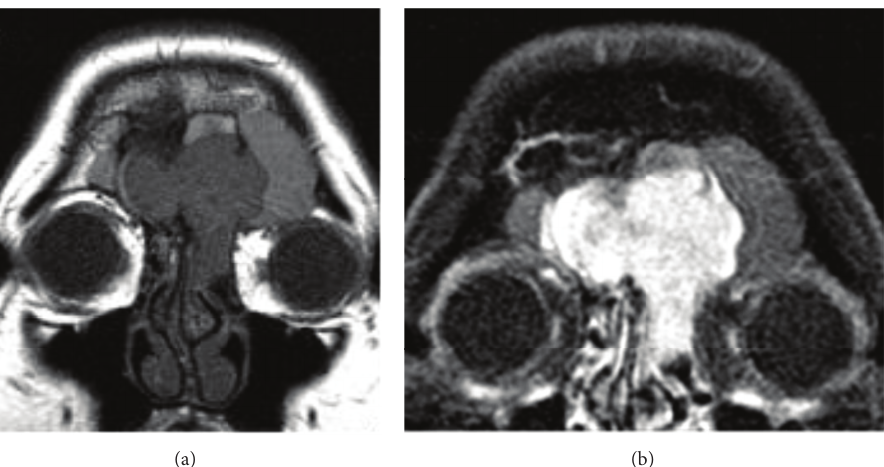
Figure 3: ((a) and (b)) Preoperative coronal MRI images showing the tumor’s frontal sinus location and (b) demonstrating tumor’s strong contrast enhancement.